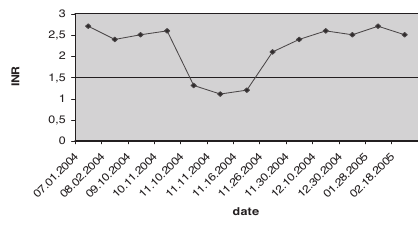
INR values of the